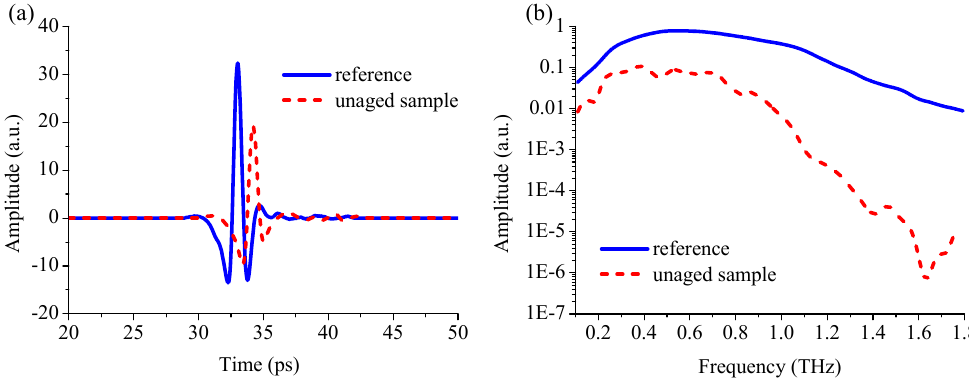
Figure 2. The THz spectra of reference and the unaged insulation paper. ( a ) The time-domain waveform; ( b ) The frequency-domain spectra.